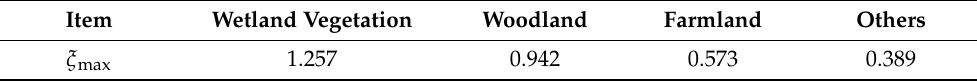
Table 1. Maximum light use efficiency ( ξ max